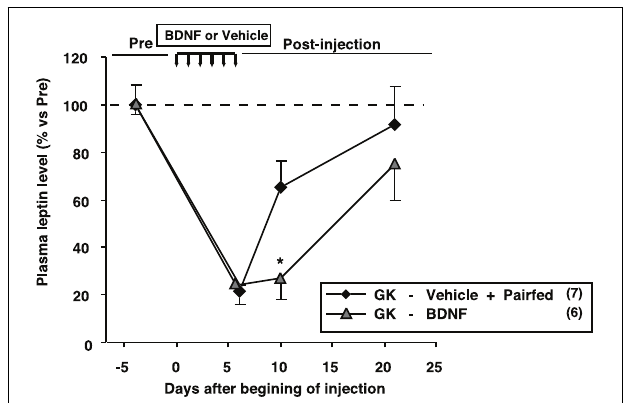
FIGURE 9 | Comparison of plasma leptin levels between GK-BDNF and GK-Vehicle pair-fed groups. In both groups, plasma leptin levels at Day 6 were decreased after BDNF and pair-fed treatments. At Day 10, plasma leptin level in GK-BDNF group remained low while that in GK-Vehicle pair-fed group was significantly elevated ( ∗ p < 0 . 05, Student’s t